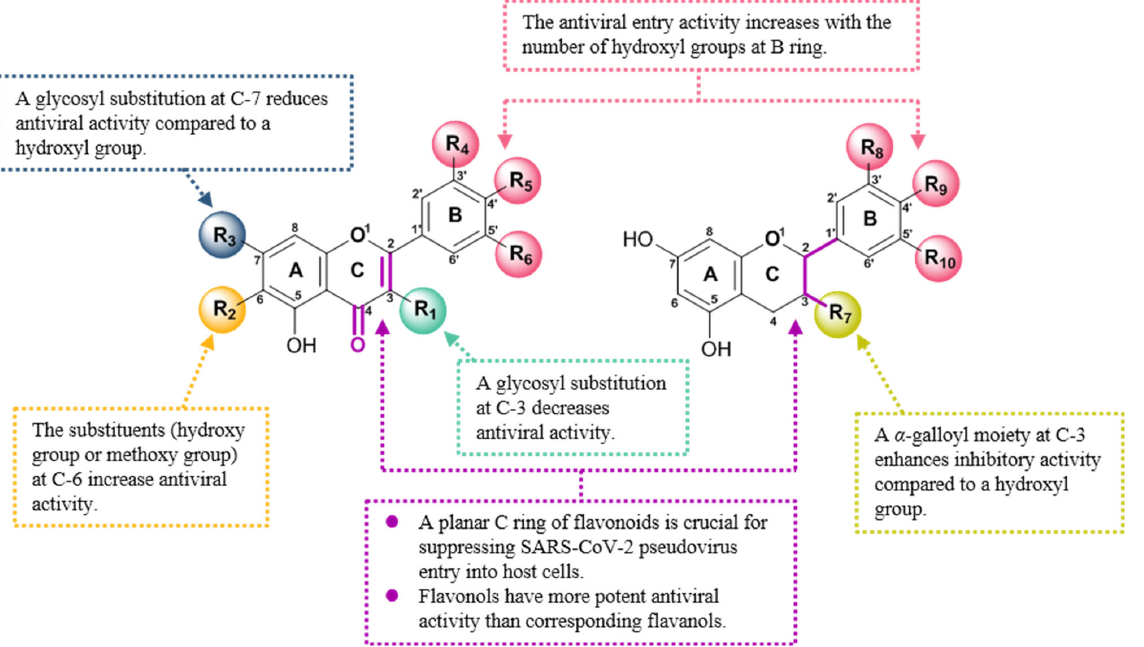
Figure 3. Summary of the structure–activity relationship of flavonoids as SARS ‐ CoV ‐ 2 entry inhib ‐